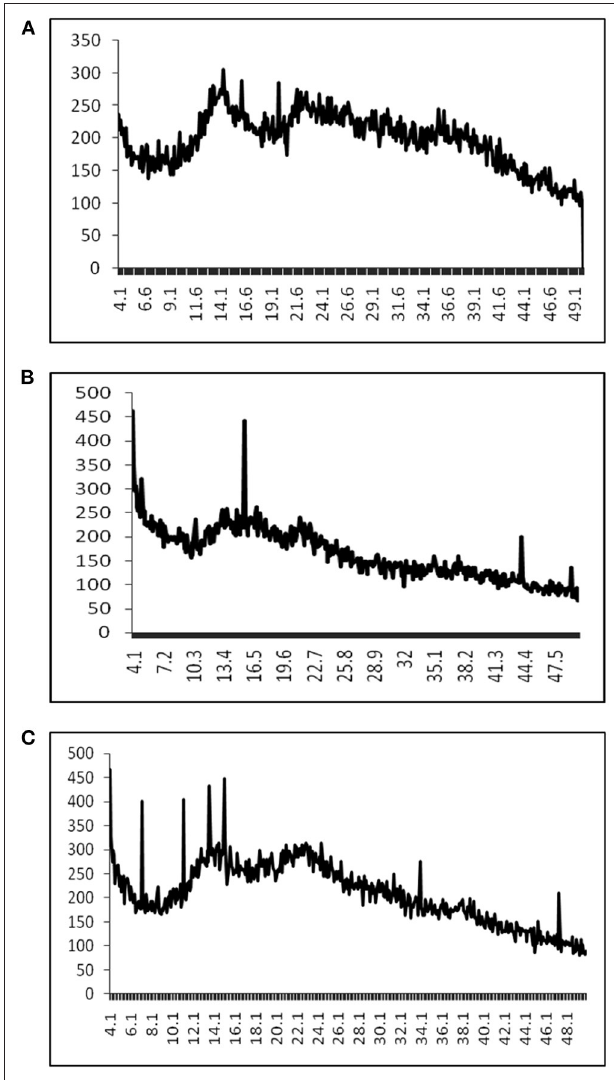
FIGURE 3 | XRD of different pectin samples, where (A–C) represents pectin from Mosambi, Kinnow, and Orange peels,